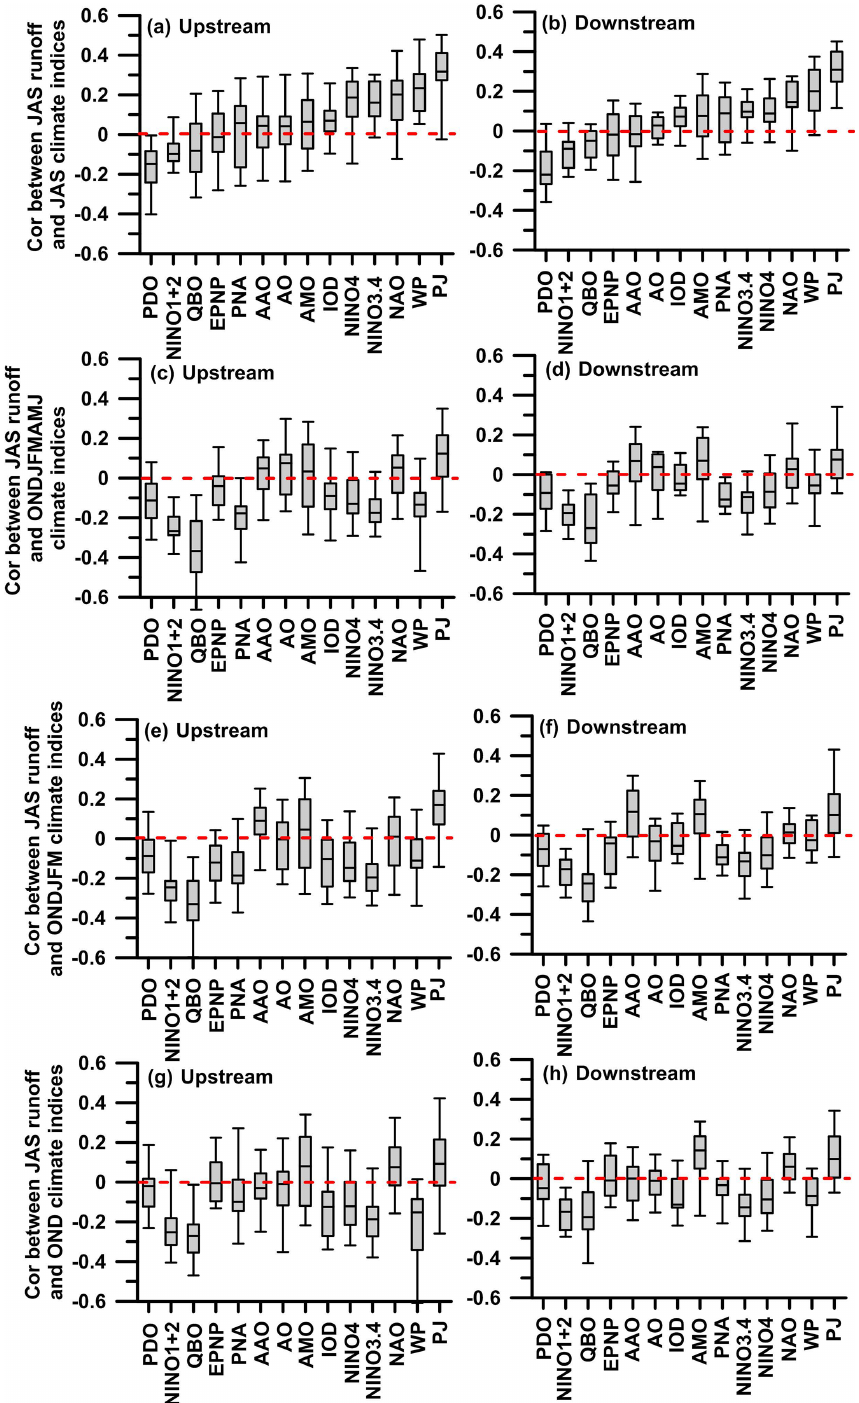
Figure 4. Box plots of correlation values of upstream (a, c, e, g) and downstream (b, d, f, h) runoff with teleconnection indices. From top to bottom are concurrent to lagged correlations derived from teleconnection indices averaged over different